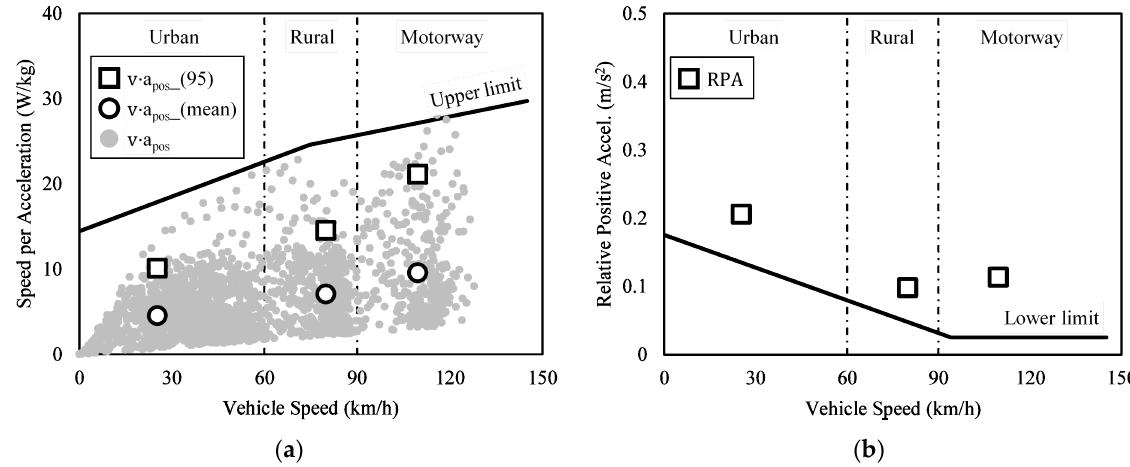
Figure 3. Verification of trip validity using MAW method. ( a ) Speed per acceleration vs. vehicle speed. ( b ) Relative positive acceleration vs. vehicle speed.